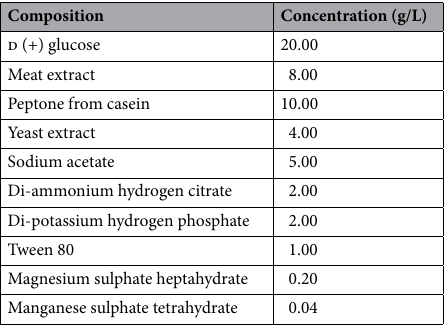
Table 8. Composition of de Man,Rogosa and Sharpe (MRS)